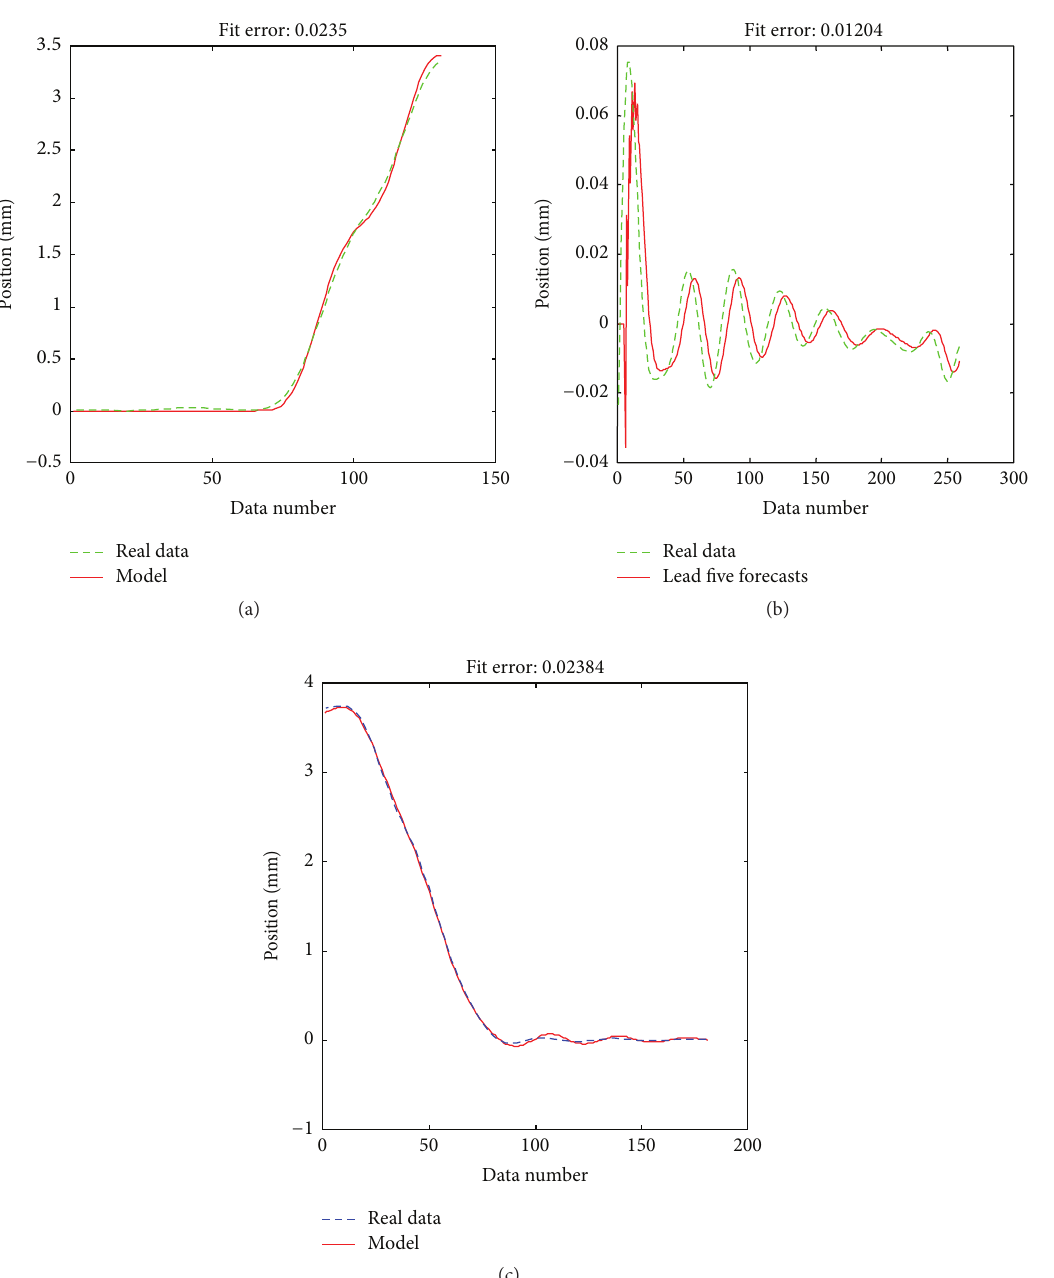
Figure 14: Model verification for the subsystem B for 240 rpm operation speed: (a) section 1 , (b) section 2 , and (c) section 3 .